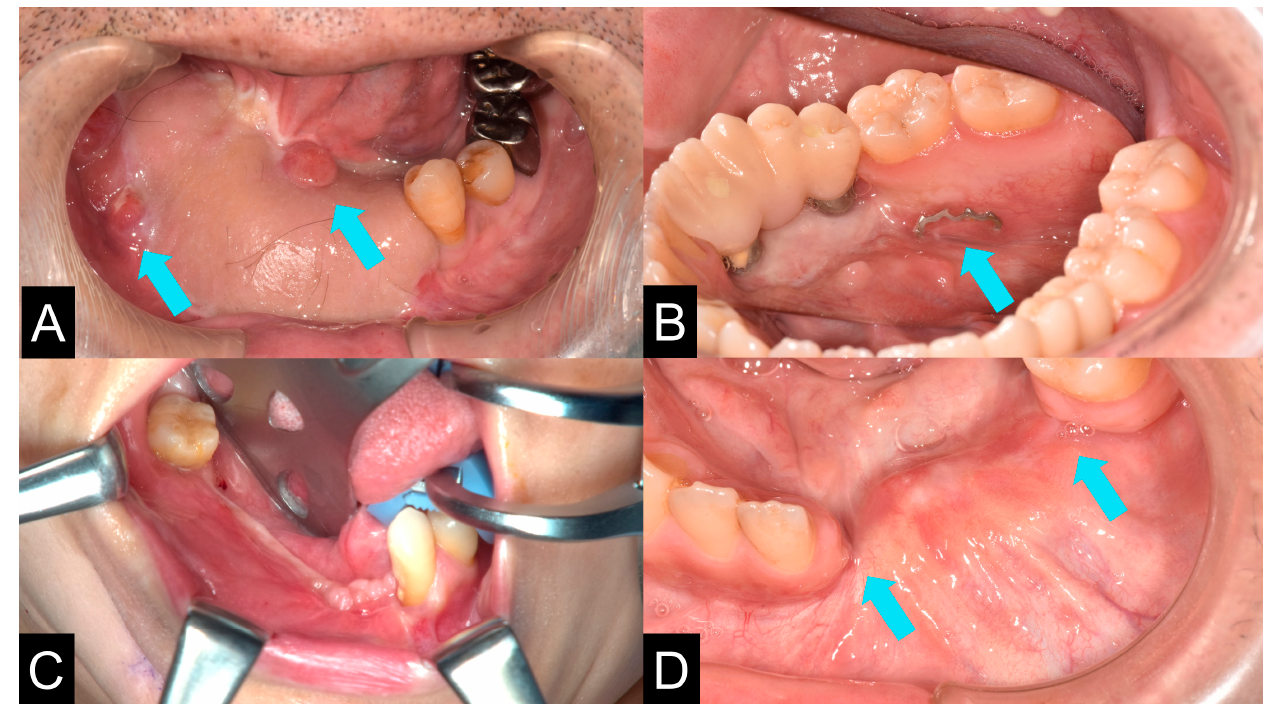
Figure 16. The infectious situation of the mandible ( A ). Chronic pus discharge was observed after surgery. The arrows indicate the location of the fistula and the growth of inflammatory granulation tissue. The patient underwent removal of the infected grafted bone followed by re-grafting of PCBM. Titanium mesh exposure ( B ). Arrows indicate exposed titanium mesh. The countermeasure was the removal of the exposed mesh. The narrowing of the oral vestibule after bone graft ( C ). The gap between gingival mucosa and augmented bone. Arrows indicate the gap between the alveolar bone and the grafted bone ( D ).